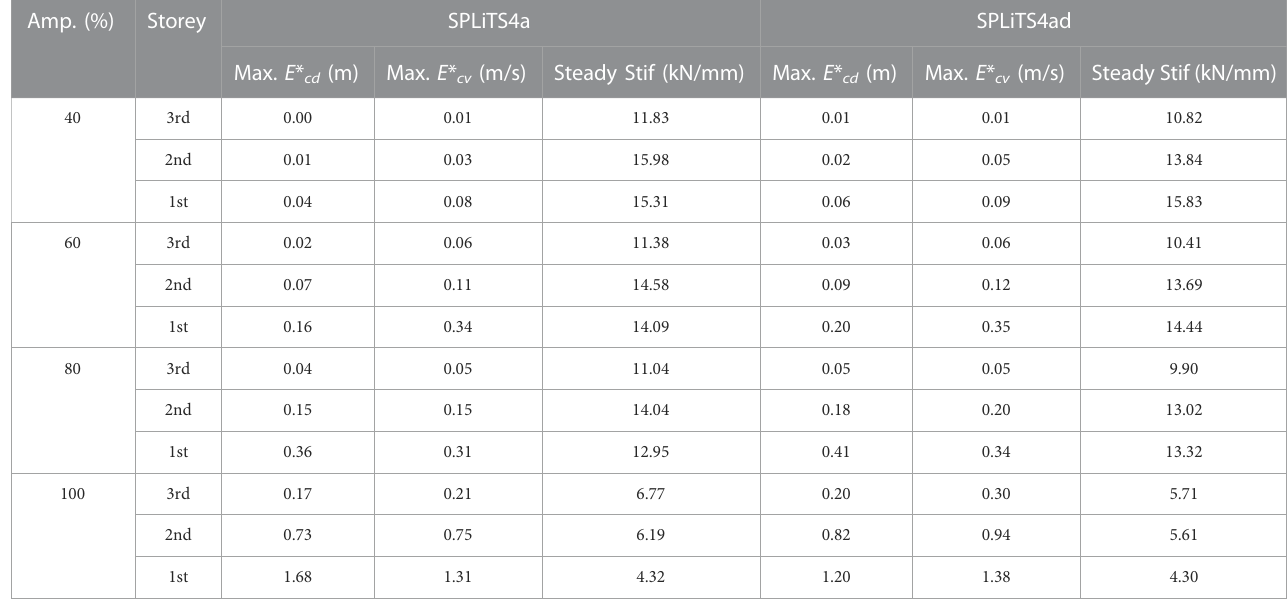
TABLE 2 Structural state indices estimated from the experiments using the Takatori motion. Amp.